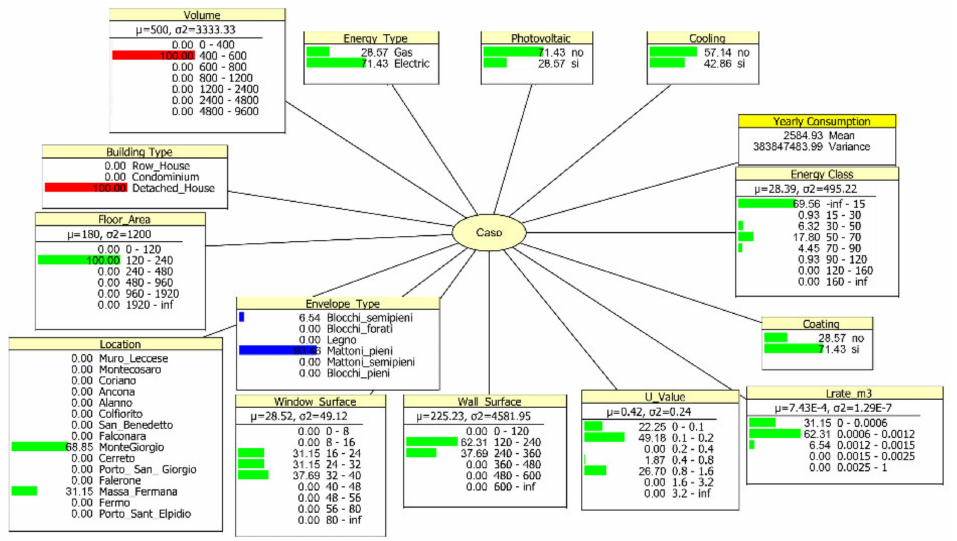
Figure 22. Searching for neighborhood cases.